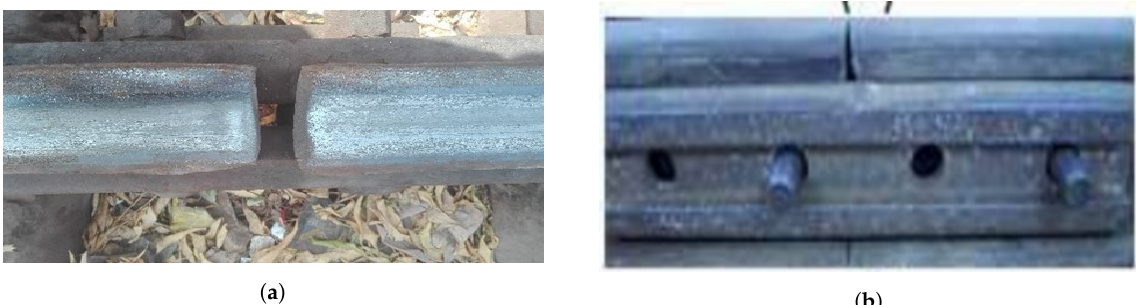
Figure 3. Surface and nuts and bolts problems of a railway track: ( a ) Damage of surface of rail head due to super elevation issue; ( b ) Absence of nuts and bolts